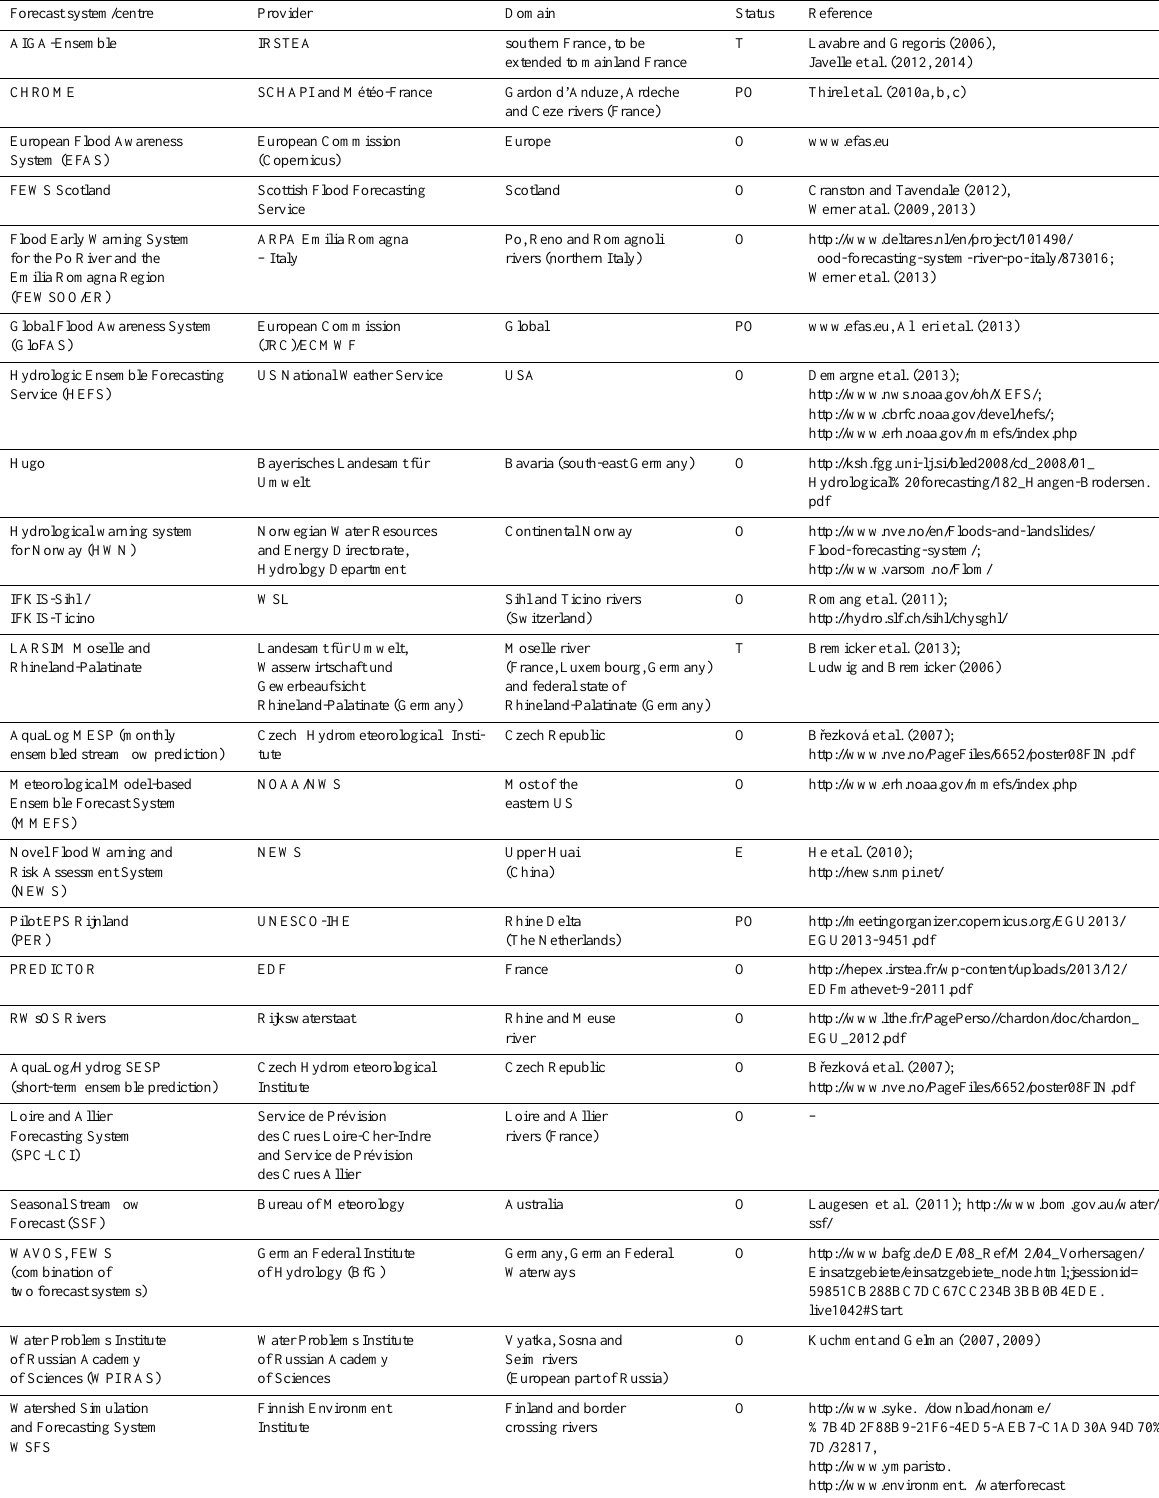
Table 1. Forecast centres with operational or pre-operational HEPS Forecast